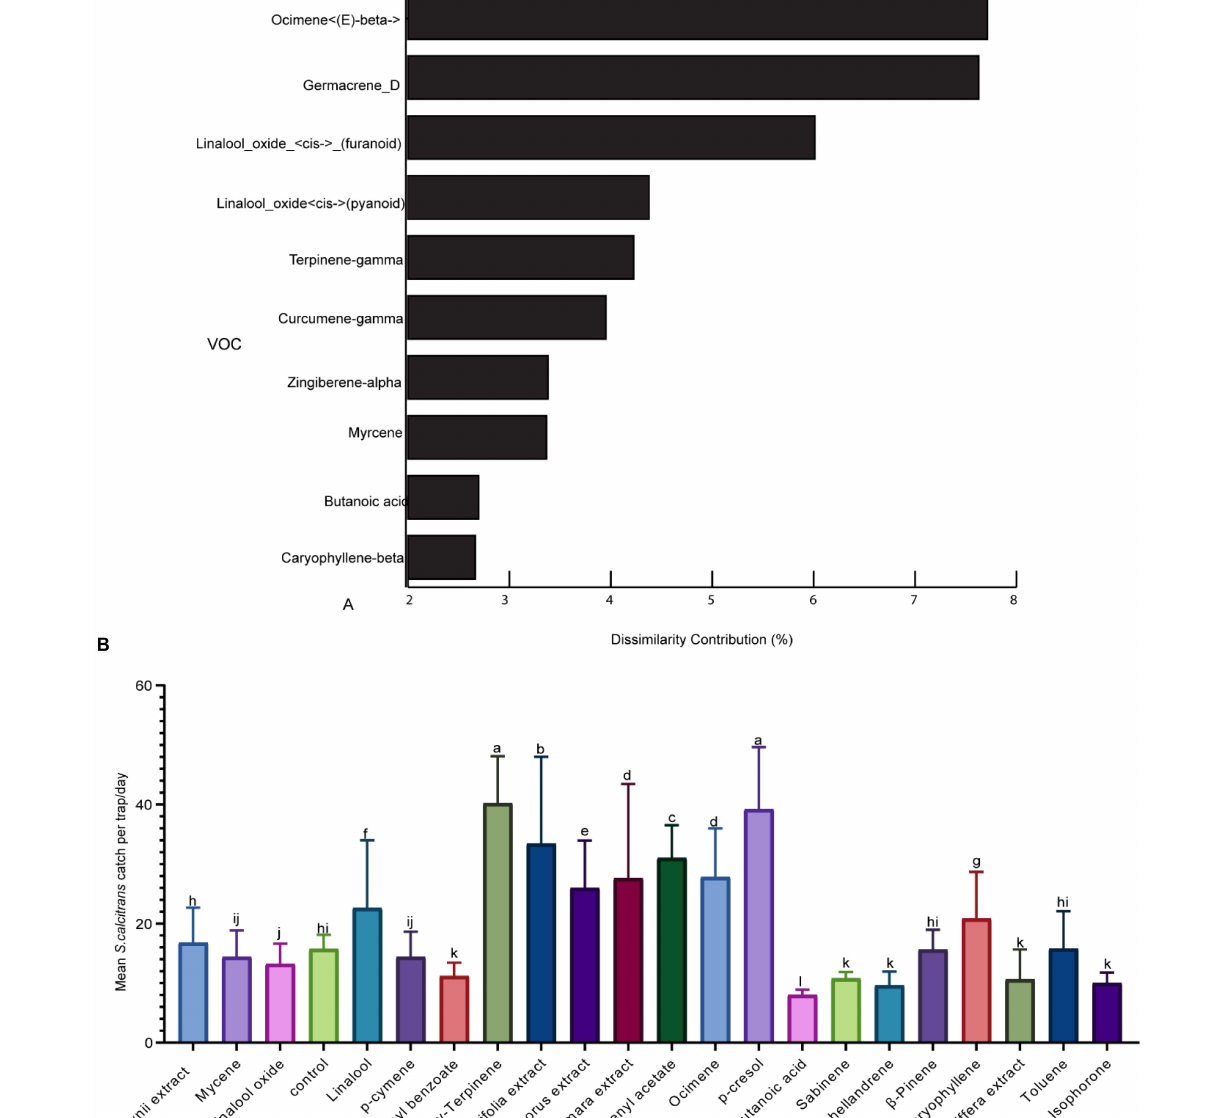
Frontiers in Physiology |